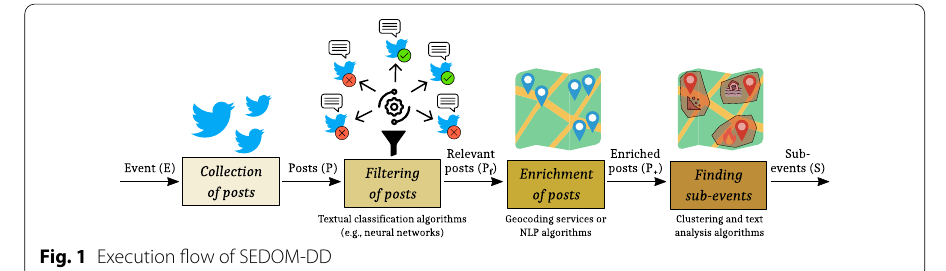
Fig. 1 Execution flow of